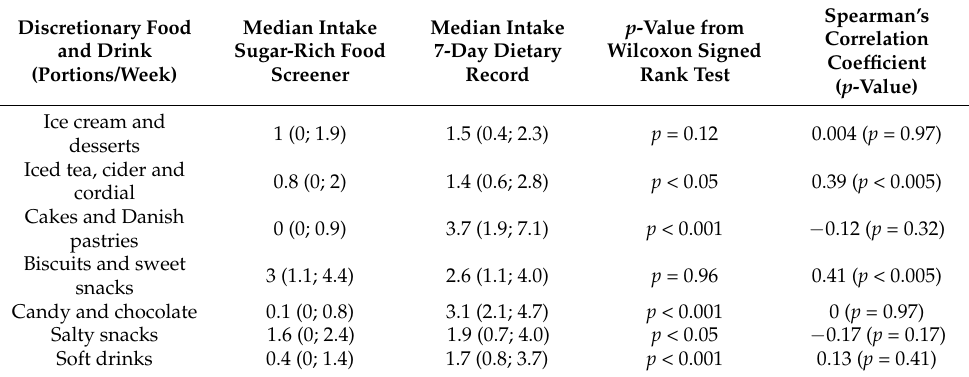
Table 4. Wilcoxon signed rank test and Spearman’s correlation coefficients for intake of discretionary foods and drinks (portions of 450 kJ/week) from the SRFS and the 7-day dietary record divided into categories ( n = 80).